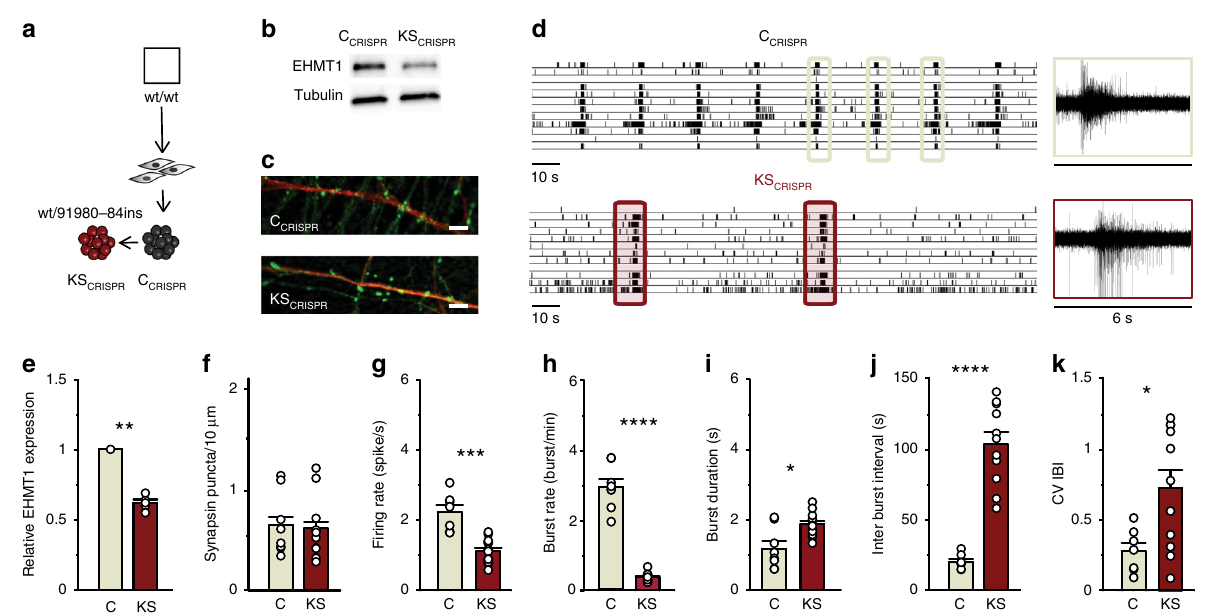
Fig. 3 Spontaneous electrophysiological activity of neuronal network derived from control- and CRISPR/Cas9-edited iPS cells. a Isogenic line: C CRISPR and KS CRISPR . b Western blot showing the EHMT1 protein levels in iPS cells. c Representative images of iNeurons stained for MAP2 (red) and synapsin 1/2 (green) at DIV 21 (scale bar 5 µ m). d Representative raster plots showing spontaneous activity exhibited by C CRISPR and KS CRISPR at DIV 28 on MEAs. Totally, 6 s of raw data showing a burst recorded from a representative channel are shown. e Quanti fi cation of relative EHMT1 protein level, n = 5. f Quanti fi cation of synapsin puncta in C CRISPR and KS CRISPR iNeurons, n = 9 for C CRISPR ; n = 13 for KS CRISPR . g – k Quanti fi cation of network parameters as indicated, n = 7 for C CRISPR ; n = 12 for C CRISPR . Data represent means ± SEM. * P < 0.05, ** P < 0.005, *** P < 0.0005, **** P < 0.0001, one-way ANOVA test and post hoc Bonferroni correction was performed between controls and KS networks and Mann – Whitney test was performed between two groups. Source data is available as a Source Data fi